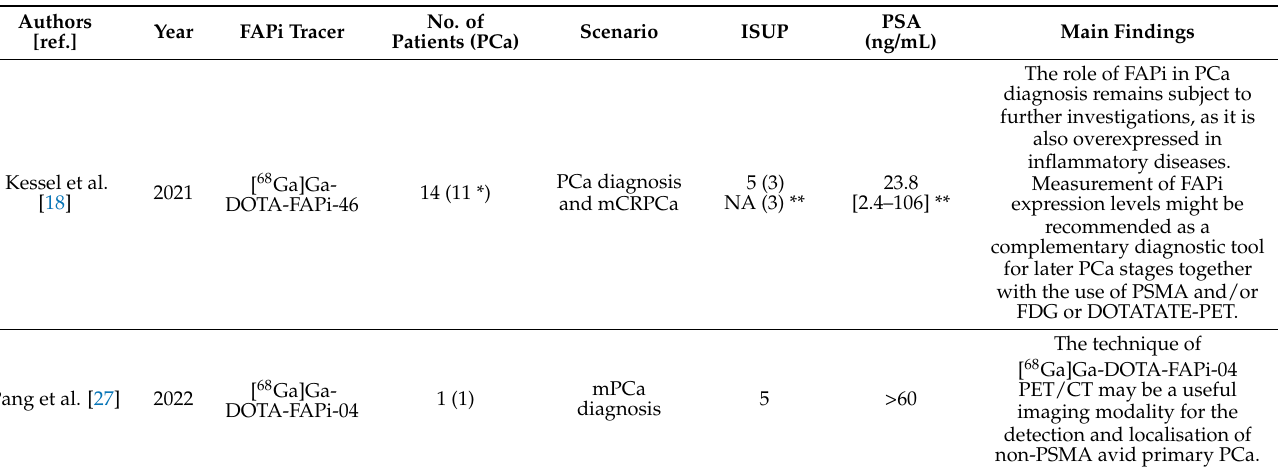
Table 2. R é sum é of the described studies that compared FAPi and PSMA PET for